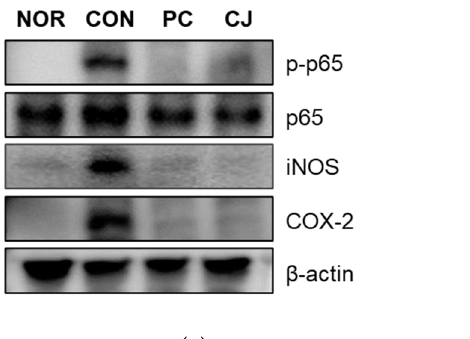
Figure 4. Effects of CJ on AOM/DSS-induced CAC-associated signaling pathways: ( a ) protein levels of phosphorylated p65, p65, iNOS, and COX2; and mRNA levels of ( b ) iNOS and ( c ) COX-2. Values are means ± standard deviation ( n = 8); NOR, normal group; CON, control group; PC, positive control group; CJ, cheonggukjang treated group. #, p < 0.05 versus normal group; ***, p < 0.001 versus control group.